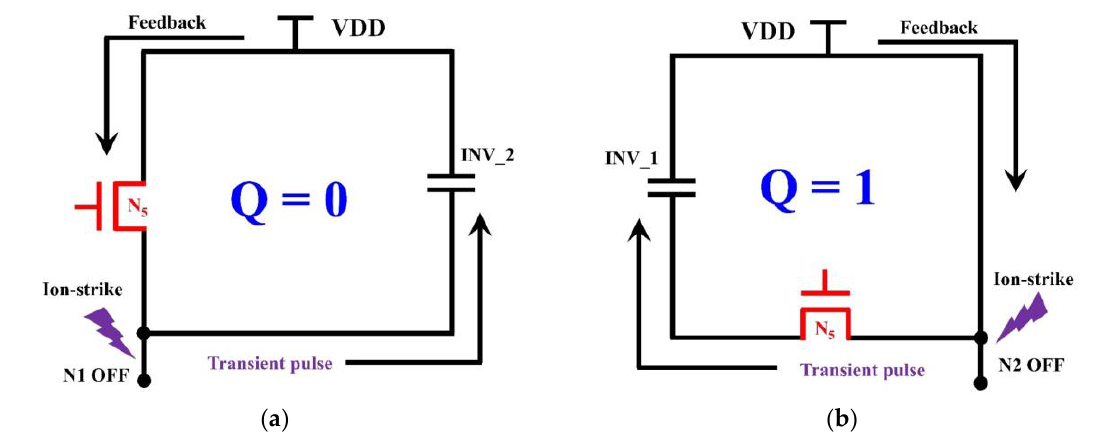
4.1. Transient Propagation Circuit Analysis for 7T SRAM